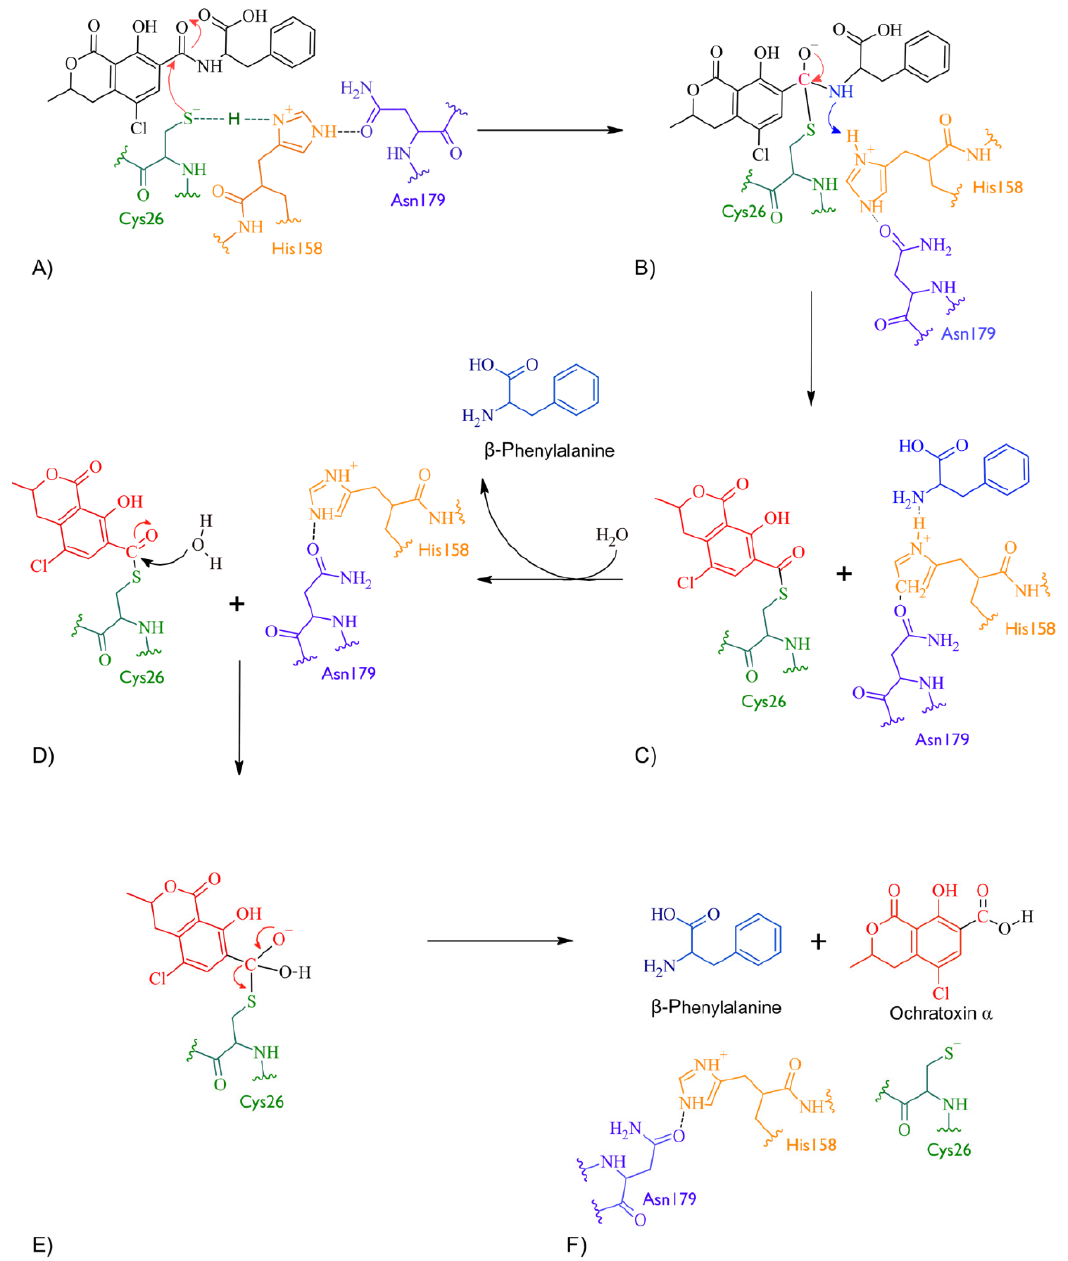
Figure 5. The detoxifying mechanism of OTA by bromelain. ( A ) Cys26 in bromelain attacks the carbonyl in OTA. Cys26 in its thiolate form and the imidazole side chain of His158 is protonated and therefore positively charged, forming an ion pair. ( B ) An intermediate is formed between Cys26 in bromelain and OTA. The electron pair is restored and the double bond between the carbonyl and oxygen is re-established. The amino group in the amide interacts with Hys158 and the amide bond breaks. ( C ) An intermediate is formed between Cys26 and the OTA fragment containing the carbonyl and another intermediate between Hys158 and OTA’s amino -containing fragment. ( D ) The β -phenylalanine product is released and the Hys158 restored. A water molecule is used to hydrolyse the intermediate between Cys26 and OTA’s carbonyl -containing fragment. The oxygen in the water molecule attacks the carbonyl and delocalises an electron pair to the oxygen of the carbonyl. ( E ) The carbonyl double bond is restored, and the bond formed between Cys26 and OTA’s carbonyl -con- taining fragment is broken. ( F ) The amino acids at the bromelain binding site are restored and α - ochratoxin product is released.